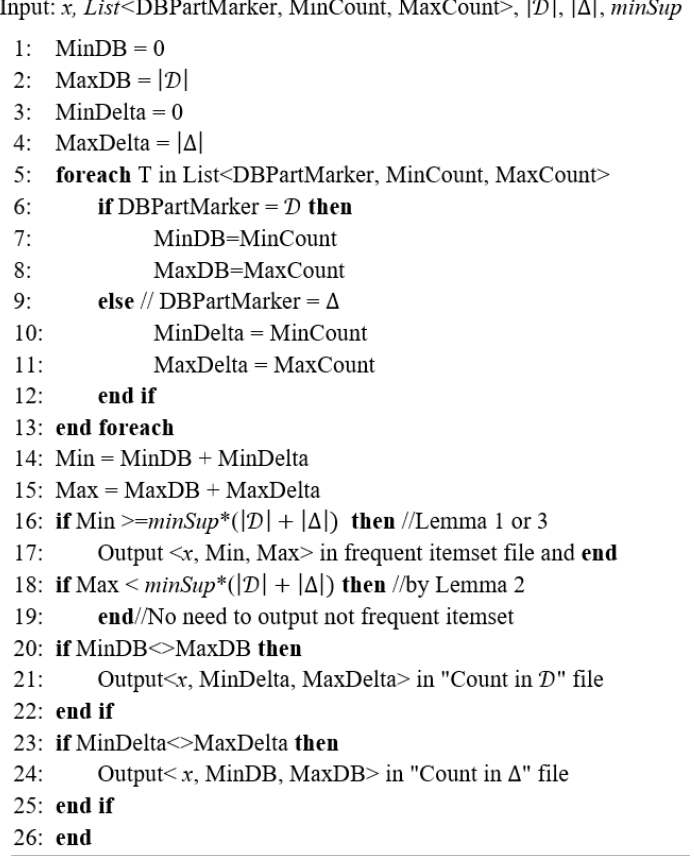
Table 4. Early pruning example values for 𝒟